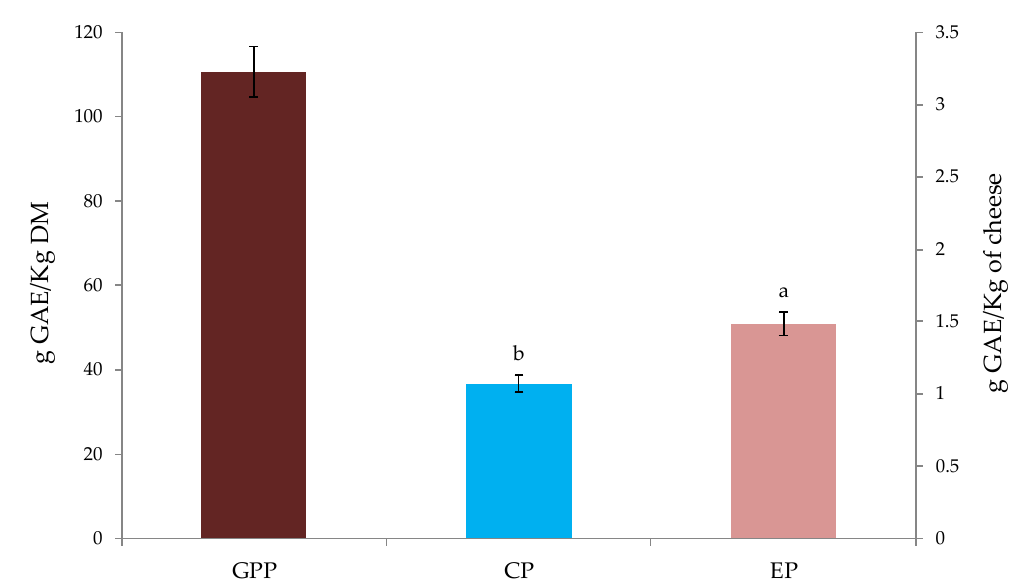
Figure 4. Total polyphenolic content (TPC) of GPP and cheese samples. Units are g GAE/Kg DM for GPP sample and g GAE/Kg for control and experimental cheese samples. Abbreviations: GPP, grape pomace powder; CP, control production inoculated with a commercial starter culture; EP, experimental production inoculated with a commercial starter culture + 1% of GPP. Results indicate mean values and standard deviation of six determinations (carried out in duplicate for three independent productions). Different superscript letters indicate significant differences on TPC according to Duncan’s test between control and experimental cheese samples for p < 0.05.